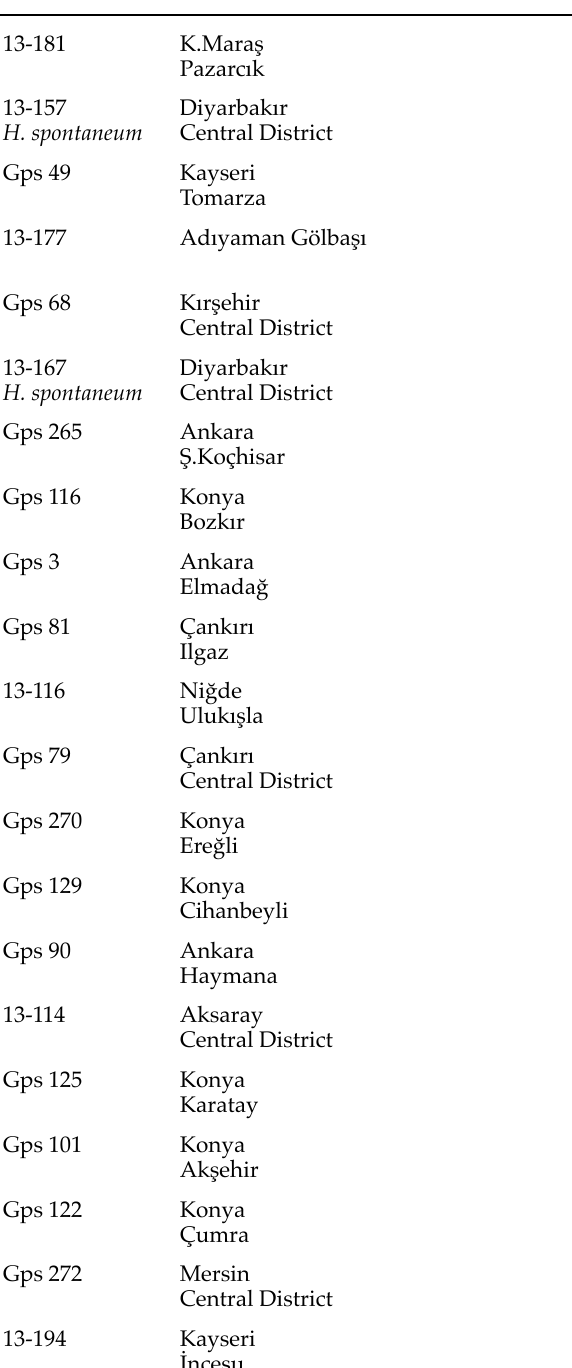
Table 1. Twenty six pathotypes of Pyrenophora teres f. maculata determined in Turkey. Isolate